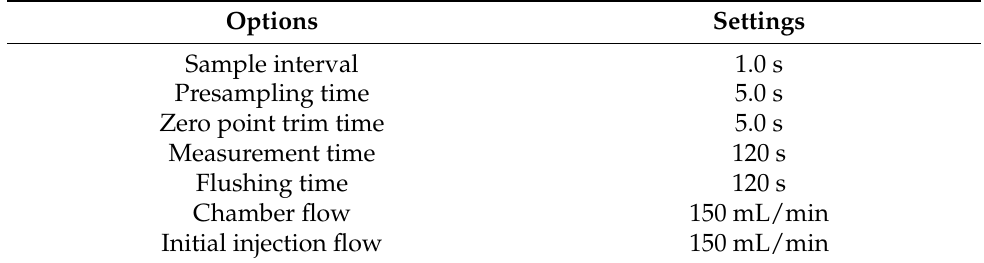
Table 3. Settings of PEN-3